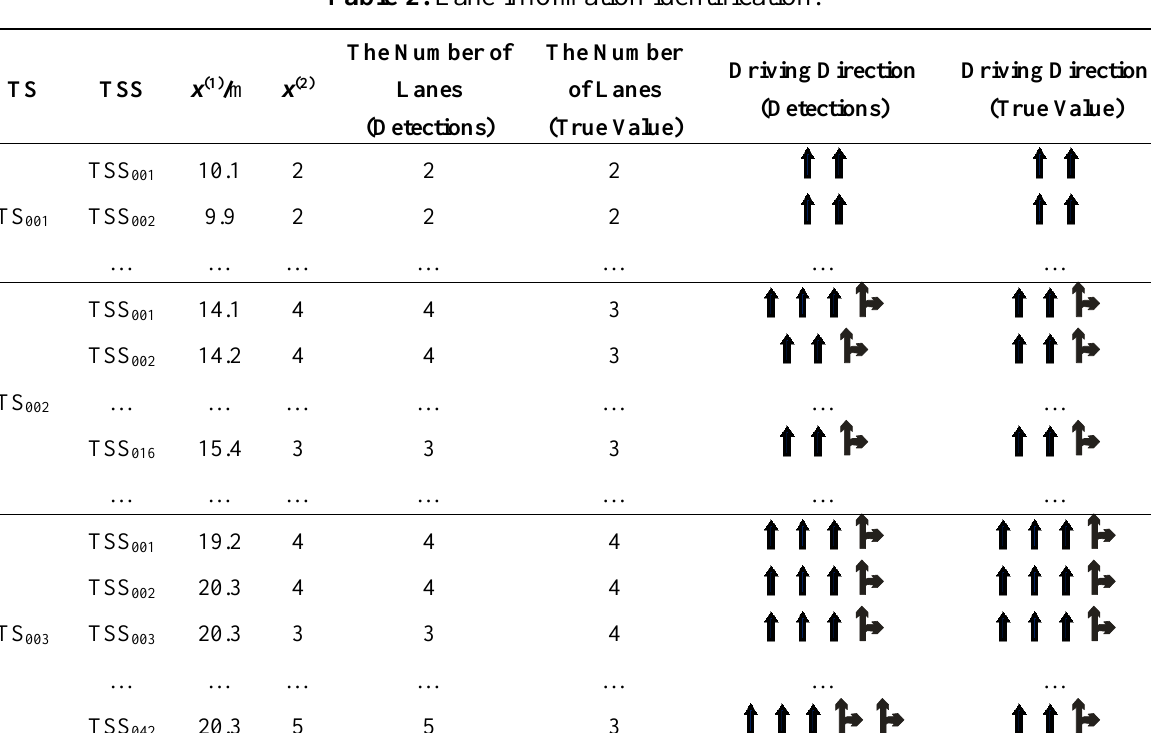
Table 2. Lane information